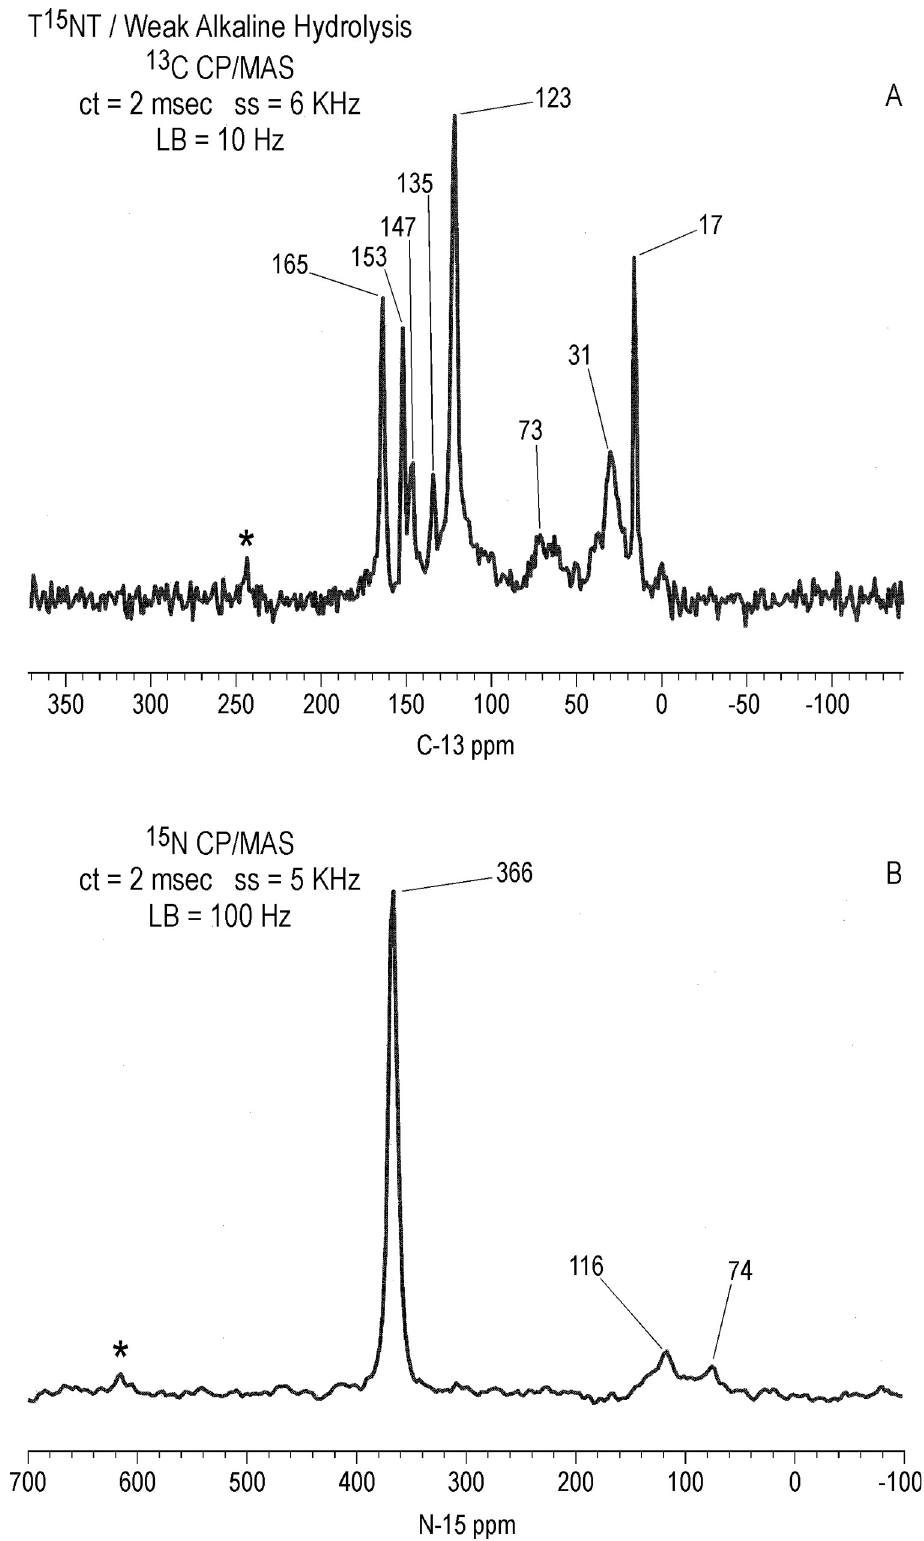
Fig 28. Solid state CP/MAS spectra of T 15 NT subjected to weak alkaline hydrolysis as dark control reaction. A. C- 13 NMR. B. N-15 NMR. ct = contact time. LB = line broadening. SS = spinning speed. Asterisk = spinning side band. https://doi.org/10.1371/journal.pone.0224112.g028 PLOS ONE | https://doi.org/10.1371/journal.pone.0224112 October 22,